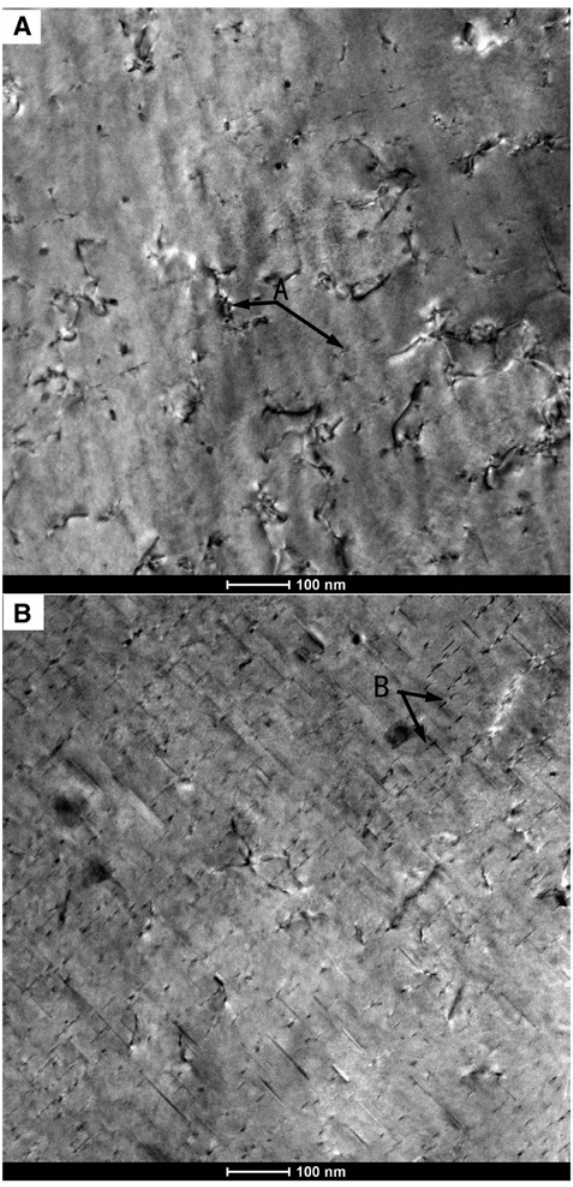
Figure 4: TEM graphs of (A) sample 1 and (B) sample 3 after aging for 10 h at 175 ° C.